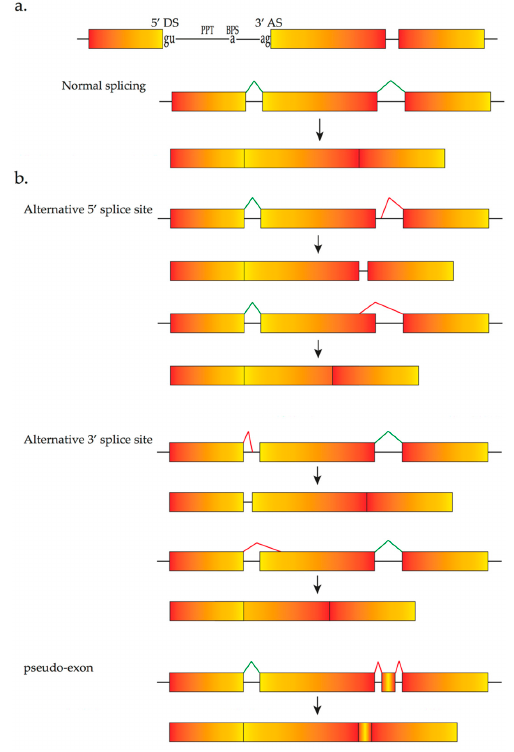
Figure 1. ( a ) Schematic representation of a cis- acting sequence, normal splicing and out of/in-frame transcripts from different mutations; ( b ) abnormal splicing resulting from various mutations of DNA that weaken/strenghthen the normal/cyrptic splice sites. Boxes represent exons and black lines are introns. Red lines, arrows and asterisks represent aberrant splicing processes and mutations, respectively.